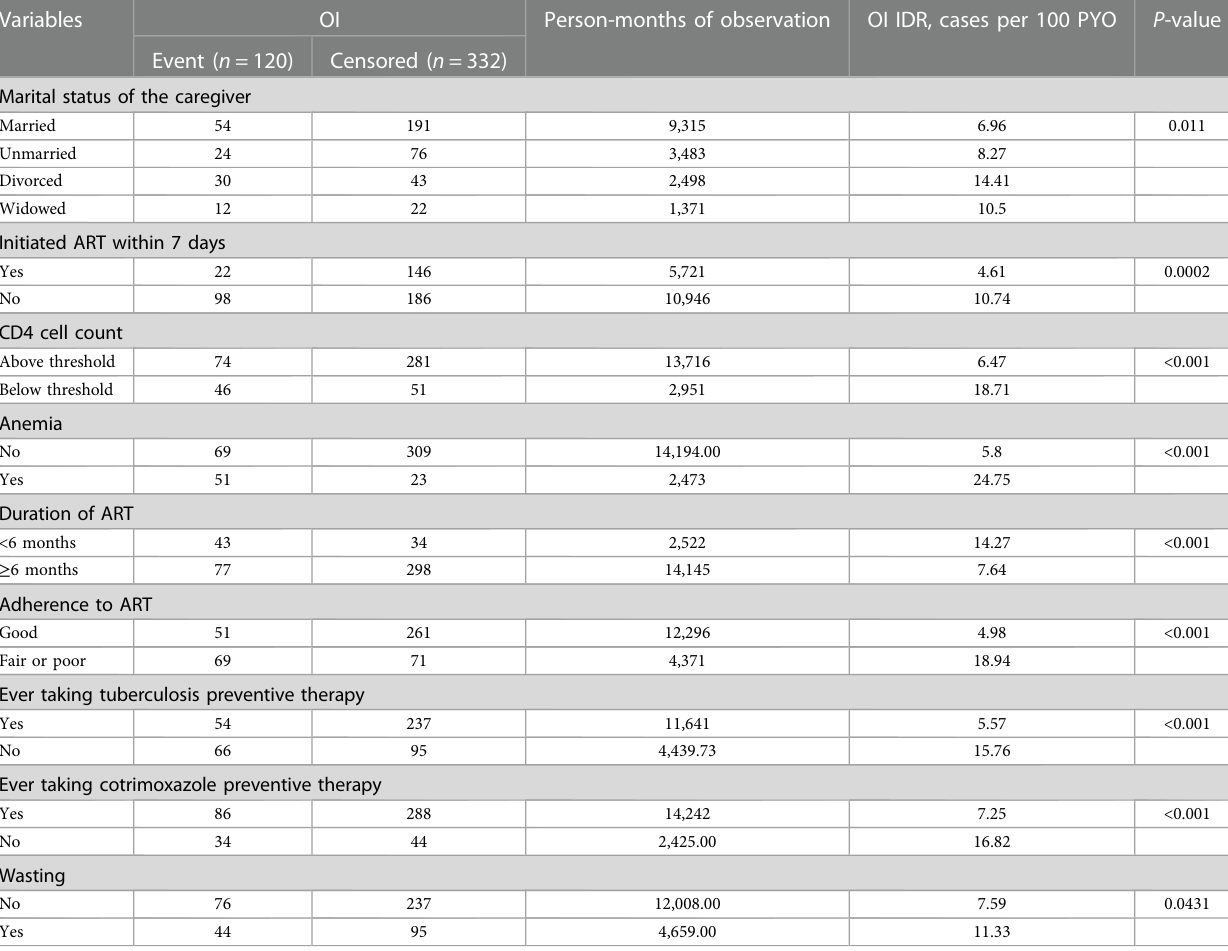
TABLE 6 Incidence of opportunistic infections (cases per 100 PYO) among HIV-infected children receiving ART in Amhara regional state comprehensive specialized hospitals, 2022 ( n =452), strati fi ed by variables investigated. Variables OI Person-months of